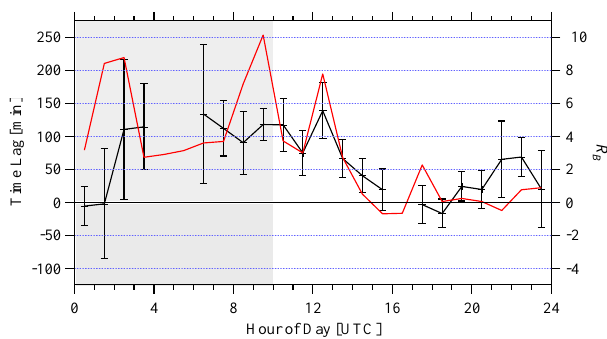
Figure 12. Average time lag of 2-m concentration signal behind 33-m signal (black line) 2 Fig. 12. Average time lag of 2-m concentration signal behind 33- sorted by hour of day. Error bars show 95% confidence interval. Average canopy 3 m signal (black line) sorted by hour of day. Error bars show 95% Richardson number (Eq. 17) also shown (red line). Night is shaded. 4 confidence interval. Average canopy Richardson number (Eq. 17) also shown (red line). Night is